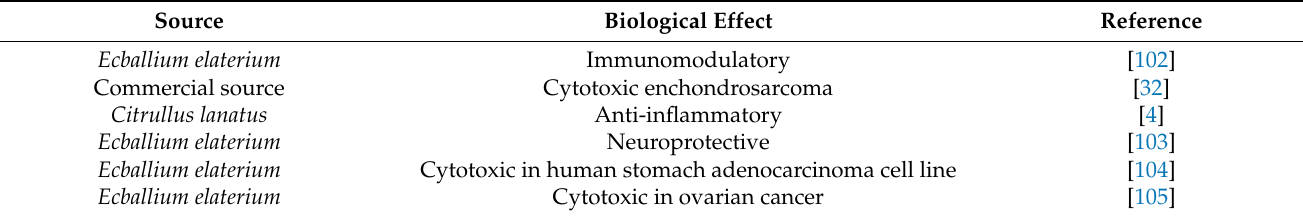
Table 3. Source and registry of the biological activity of cucurbitacin